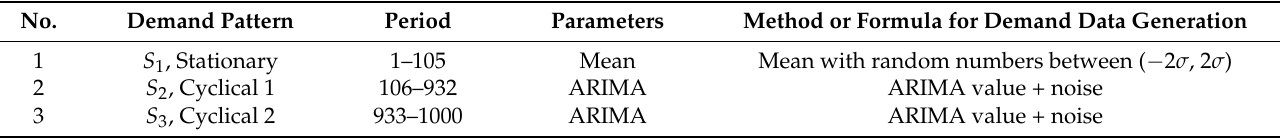
Table 6. Demand patterns, periods, and methods for random number generation.